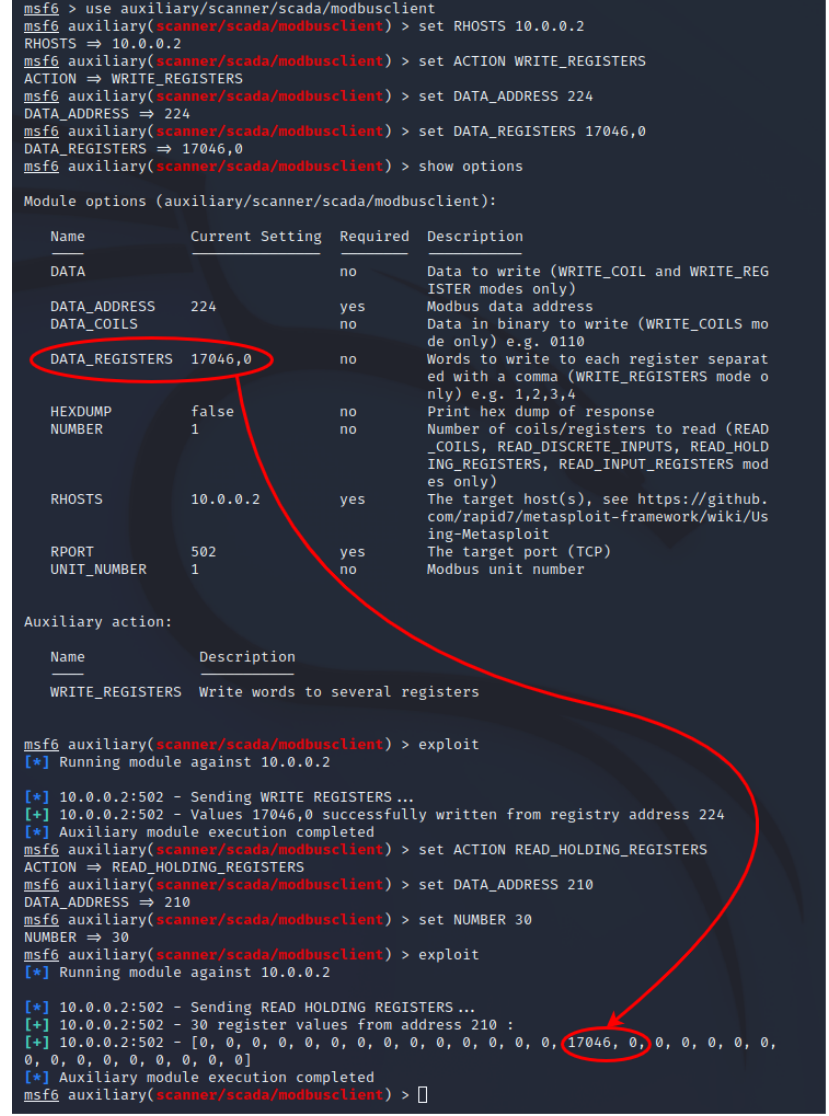
Figure 16. Metasploit Modbus injection attack example (CC_PumpSpeedCmd =